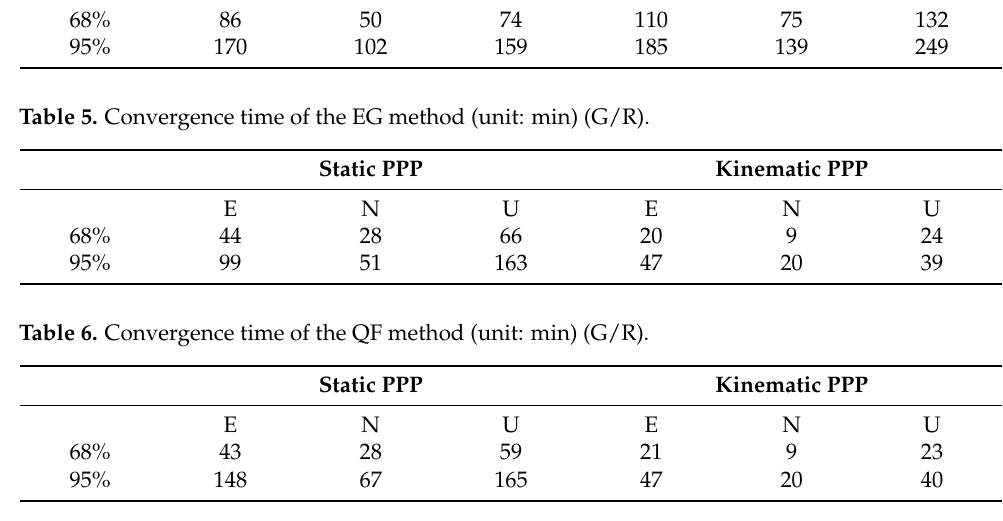
Table 7. Convergence time of the EG method (unit: min) (R/B). Static PPP